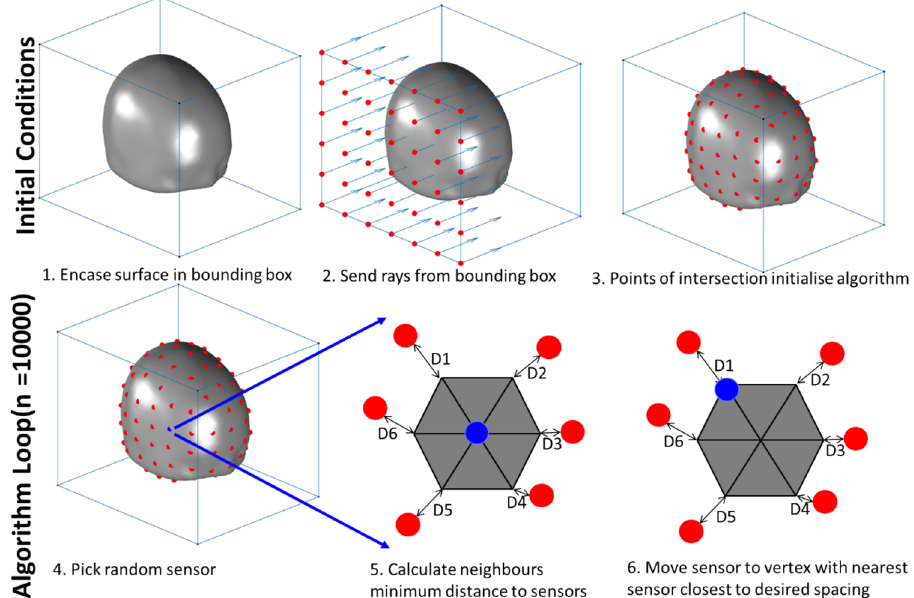
Figure 2. Algorithm for sensor placement. Initially the bounding box of the surface is subdivided into squares of edge length equal to the desired sampling density (panel 2). These points are then projected onto the surface to initialise the algorithm (panel 3). This is repeated for each face of the bounding box in the optimisation stage, at each loop iteration, a sensor is chosen at random (panel 4) and moved to a neighbouring vertex if